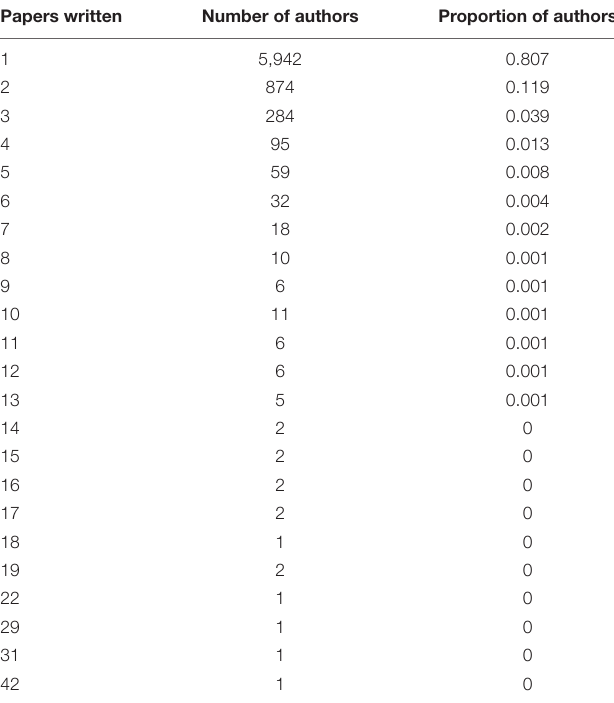
TABLE 4 | Lotka’s law statistics of papers written by authors in psycho-oncology research between 1980 and 2021. Papers written Number of authors